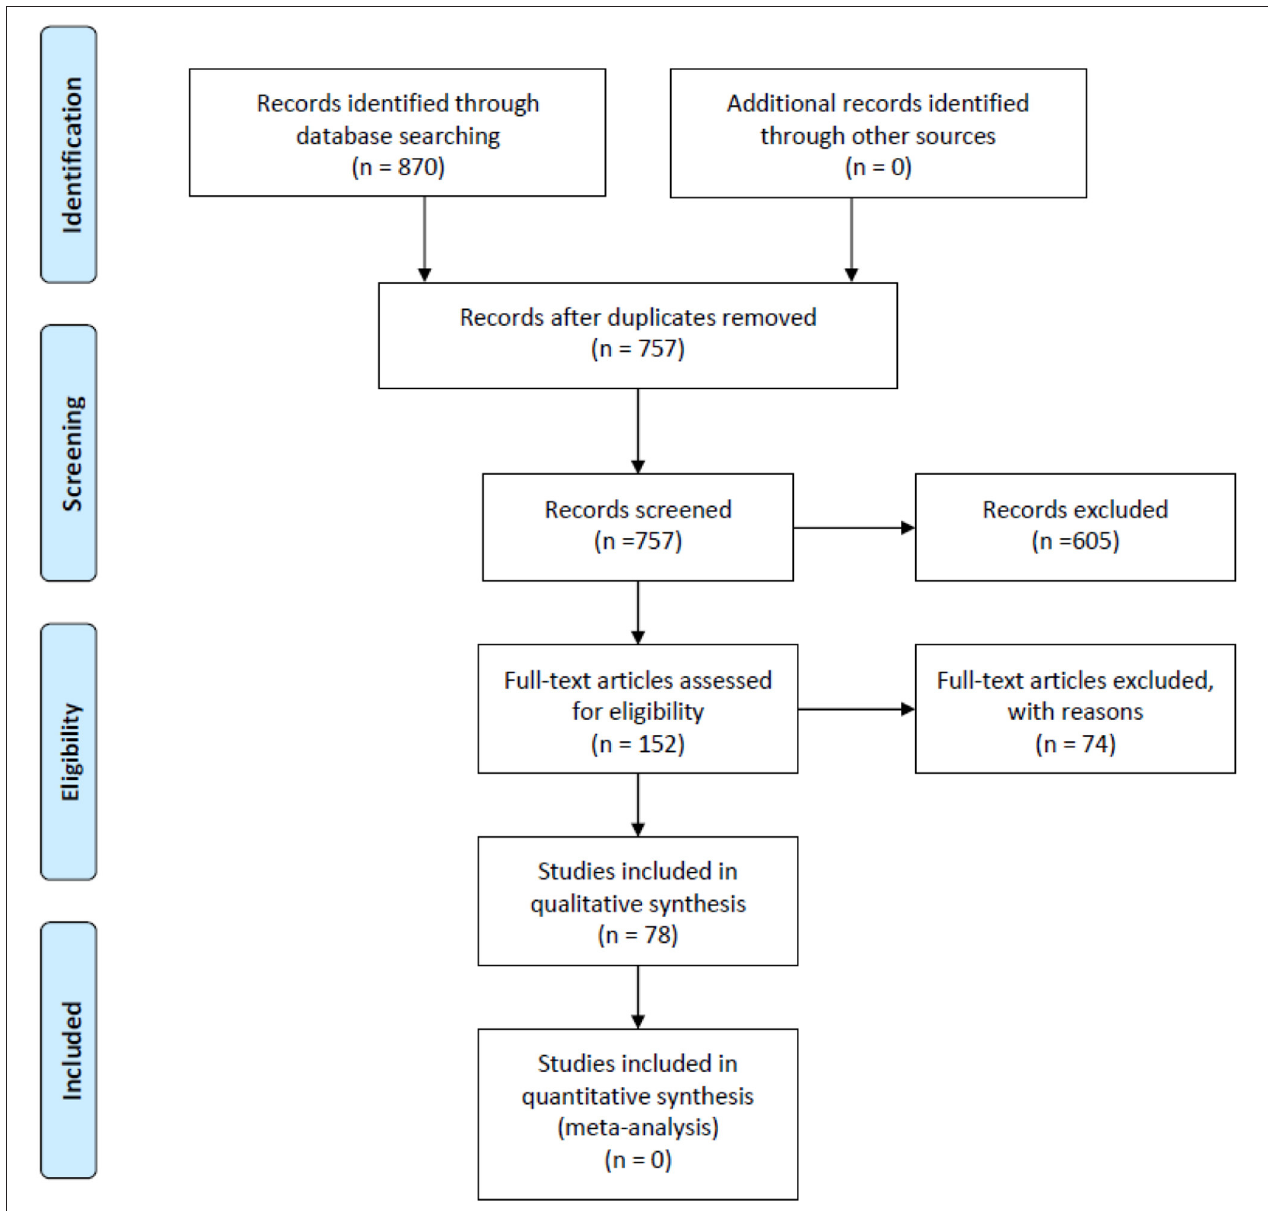
FIGURE 1 | PRISMA flow diagram for the literature search and study selection.